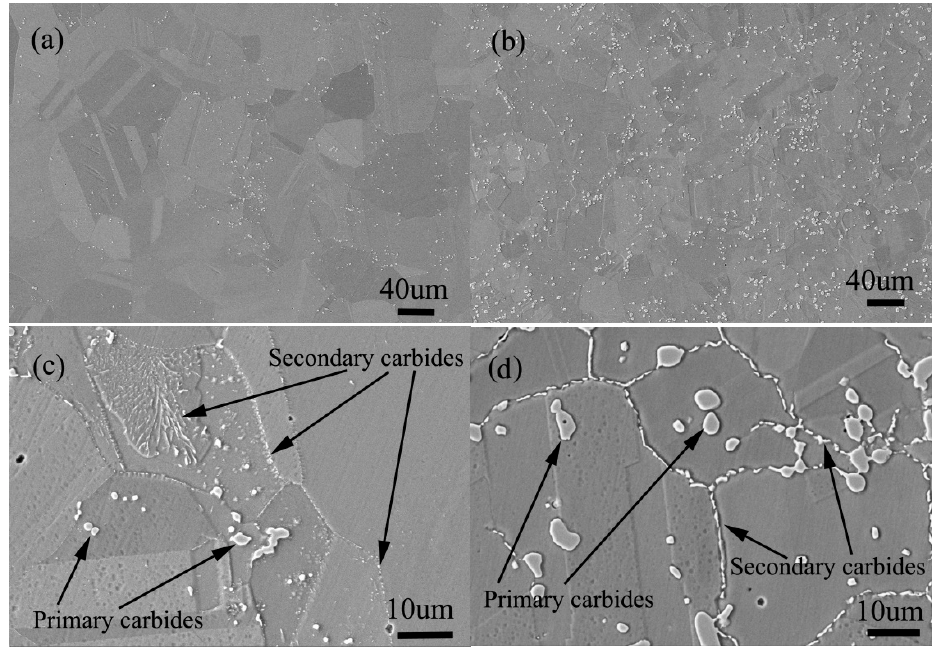
Figure 20. Microstructure of solid solution state alloy: ( a ) 0Si alloy, ( b ) 2Si alloy; Microstructure of aging state alloy: ( c ) 0Si alloy, ( d ) 2Si alloy.